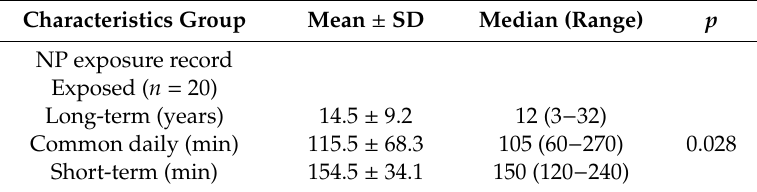
Table 5. Exposure characteristics obtained from